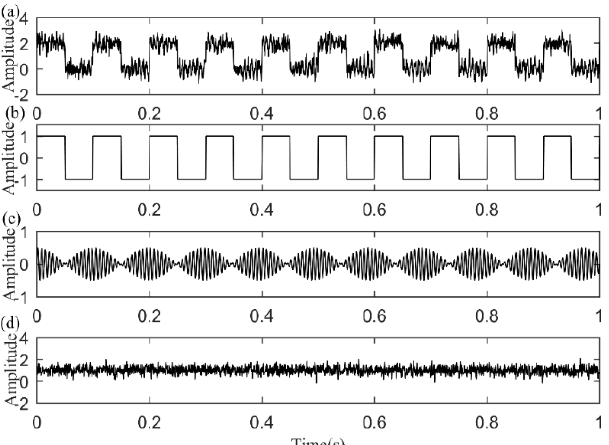
( ) x t ; ( b ) Square wave component; ( c ) AM – FM